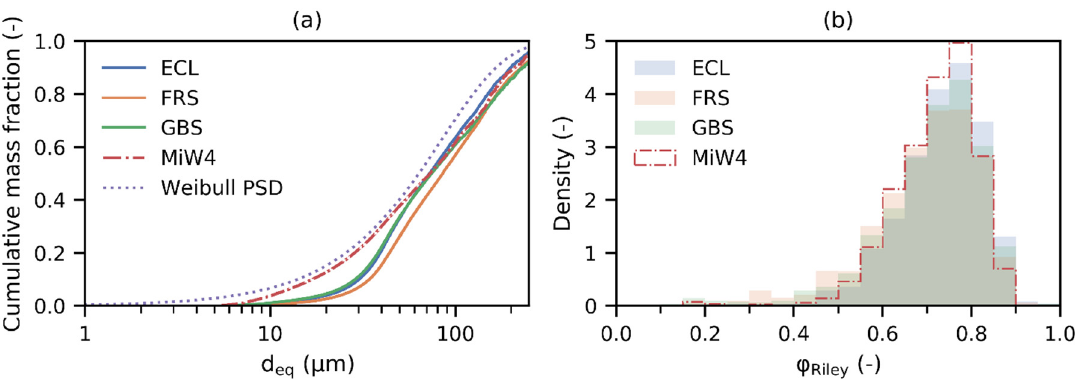
Figure 1. ( a ) Particle size distribution (PSD) of the analyzed samples and the fitted Weibull PSD used for the subsequent modeling, particle count: Eckenheimer Landstraße (ECL) n = 515,545; Frauensteinstraße (FRS) n = 593,302; Glauburgstraße (GBS) n = 540,036; MiW4 n = 501,254. ( b ) Mass fraction weighted histogram of ϕ Riley of the analyzed samples, particle count: ECL n = 130,986; FRS n = 211,209; GBS n = 134,392; MiW4 n = 57,973.